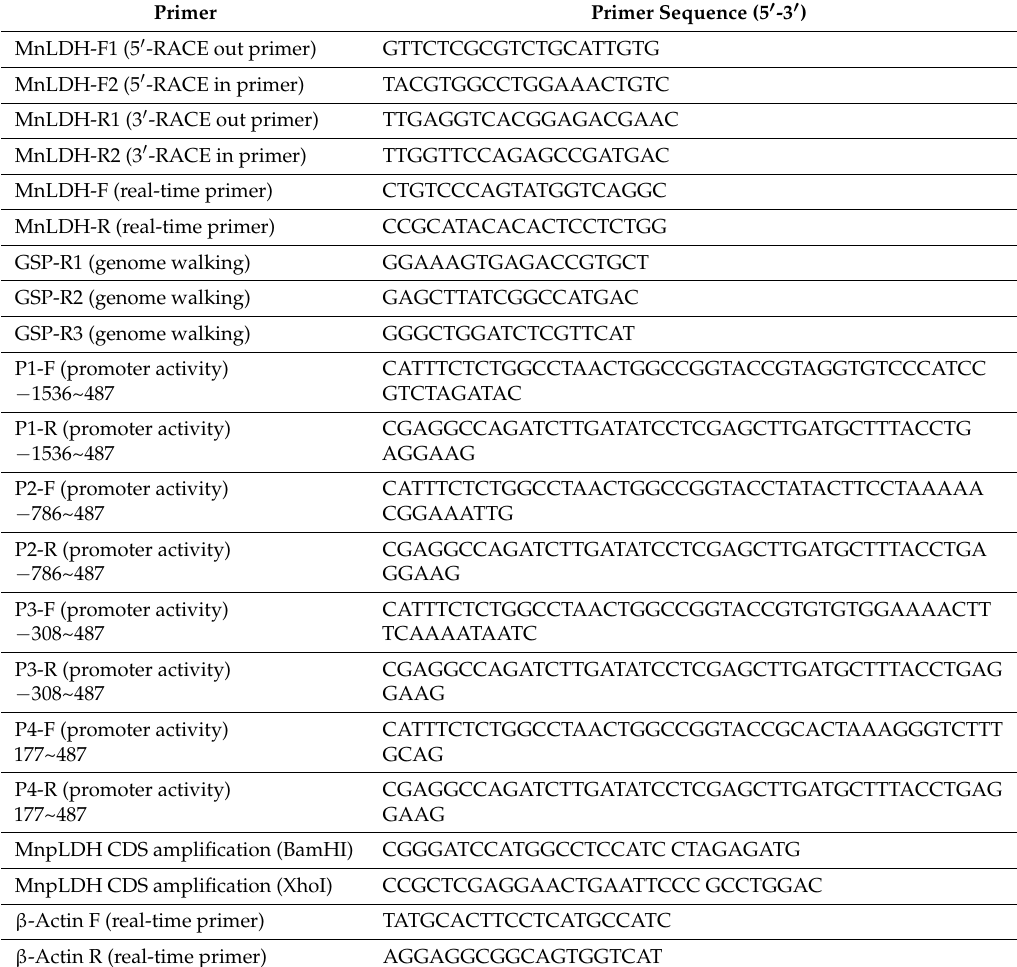
Table 1. Primers used in this